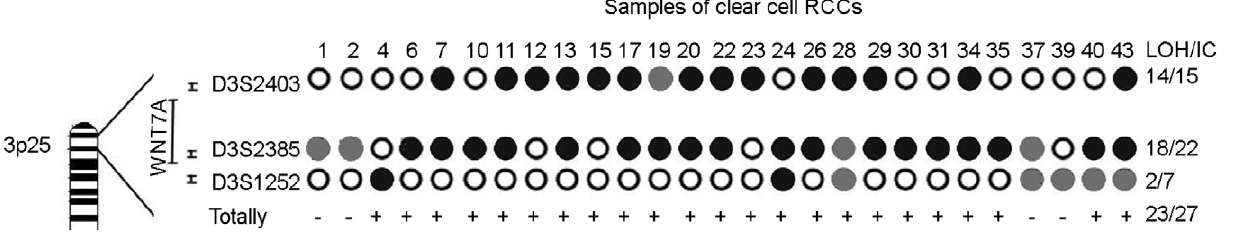
Figure 2. The LOH assays: status of the informative cases of clear cell RCC for the 3q25 region surrounding the WNT7A gene. D3S2403, D3S2385, D3S1252– microsatellite markers, white circles - homozygotes (non informative cases), grey circles – absence of the LOH, black circles – presence of the LOH, IC - informative cases, ‘‘ + ’’ - LOH positive sample, ‘‘ 2 ’’ - LOH negative sample. doi:10.1371/journal.pone.0047012.g002 PLOS ONE |